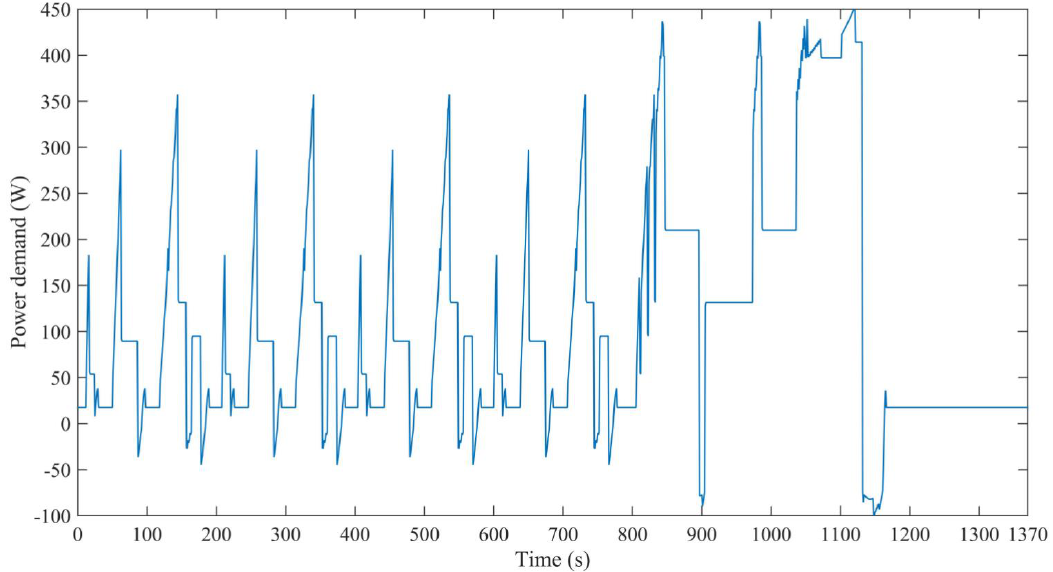
Figure 9. The power demand in simulation.